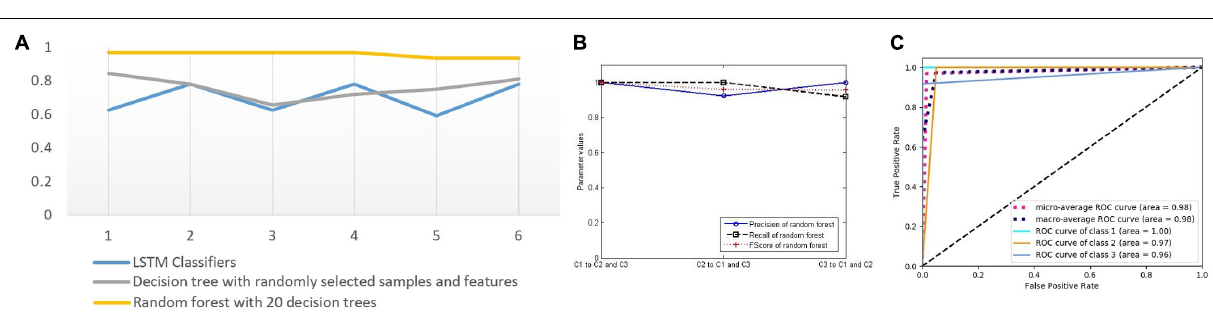
FIGURE 9 | (A) Test accuracy of four classifiers for sample group 3 (six points on the horizontal axis represent six tests). (B) Three classification performance indicators of random forest. (C) The receiver operating characteristic curves and the AUC values of